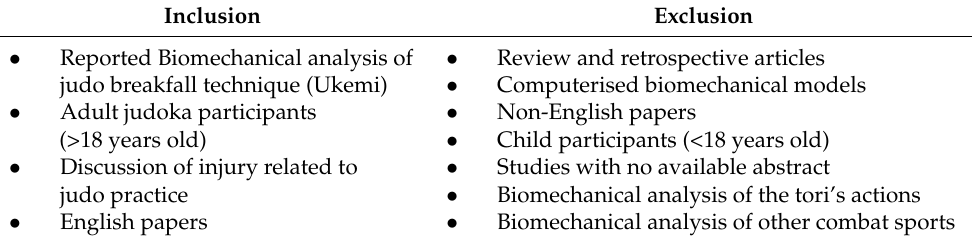
Table 1. Inclusion and exclusion